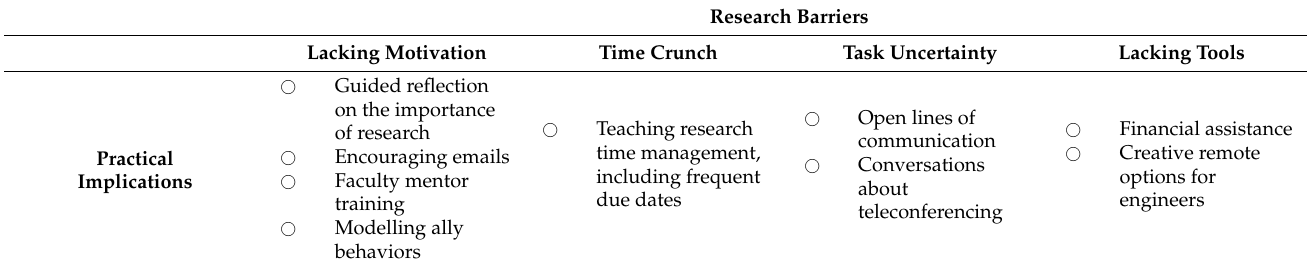
Table 6. Summary of practical implications by each barrier to research